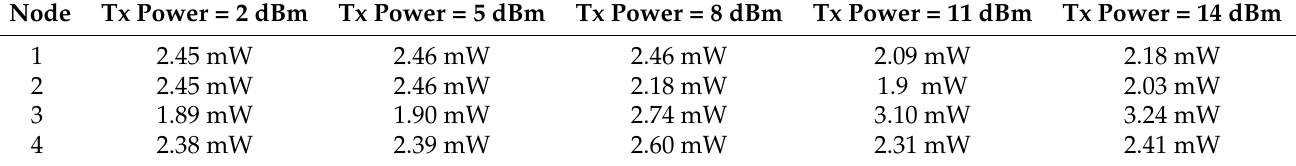
Table 4. Energy consumption of the nodes